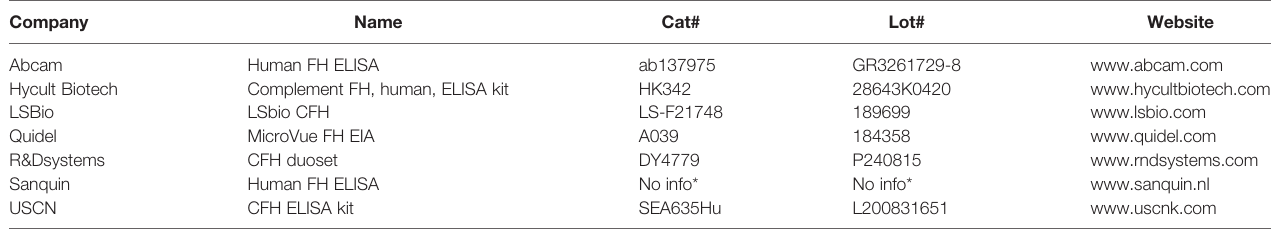
TABLE 2 | Human Factor H ELISA ’ s included in the comparison analysis.